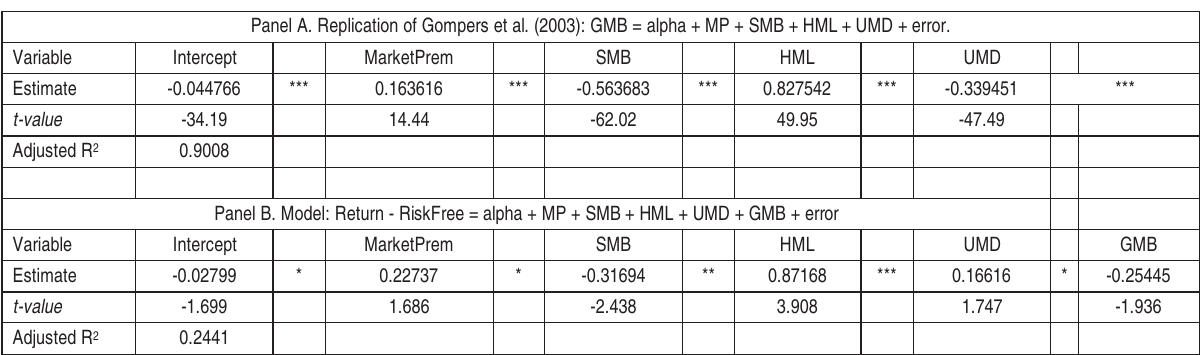
Table 3. Regression results (multiply imputed